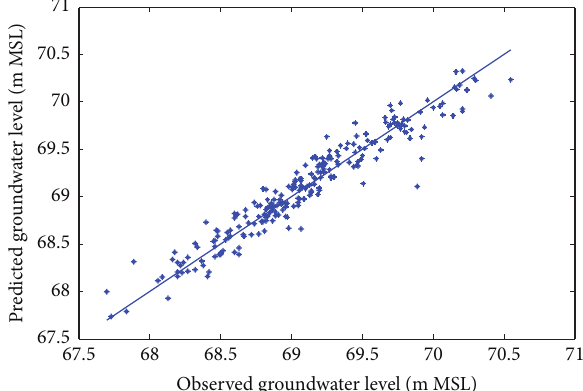
Figure9:Scatterplotsofobservedandpredictedgroundwaterlevels using an ANN trained with the Levenberg–Marquardt algorithm (Pp 930).